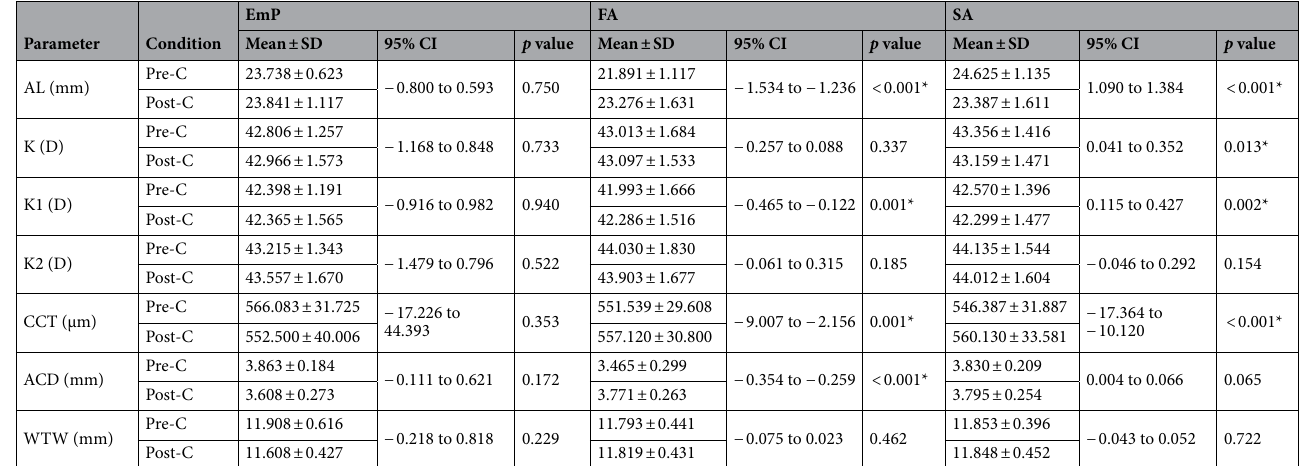
Table 3. Statistical analysis of the mean, SD, and 95% CI of ocular biological characteristics of the subjects pre- and postcycloplegia in the EmP, FA and SA groups. AL axial length; K mean keratometry, K1 flat keratometry, K2 steep keratometry, CCT central corneal thickness; ACD anterior chamber depth; WTW white-to-white distance; D dioptre; C cycloplegia; SD standard deviation; CI confidence interval. * p < 0.05 was considered statistically